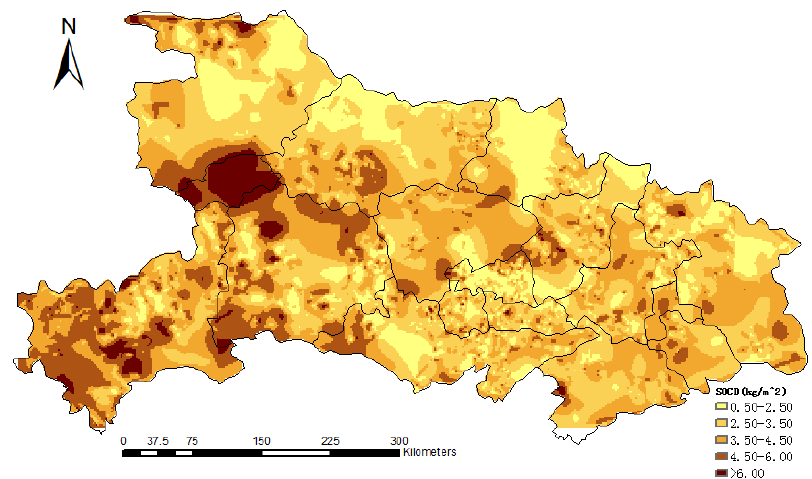
Figure 2. Spatial distribution of SOCD in Hubei Province in 2007.